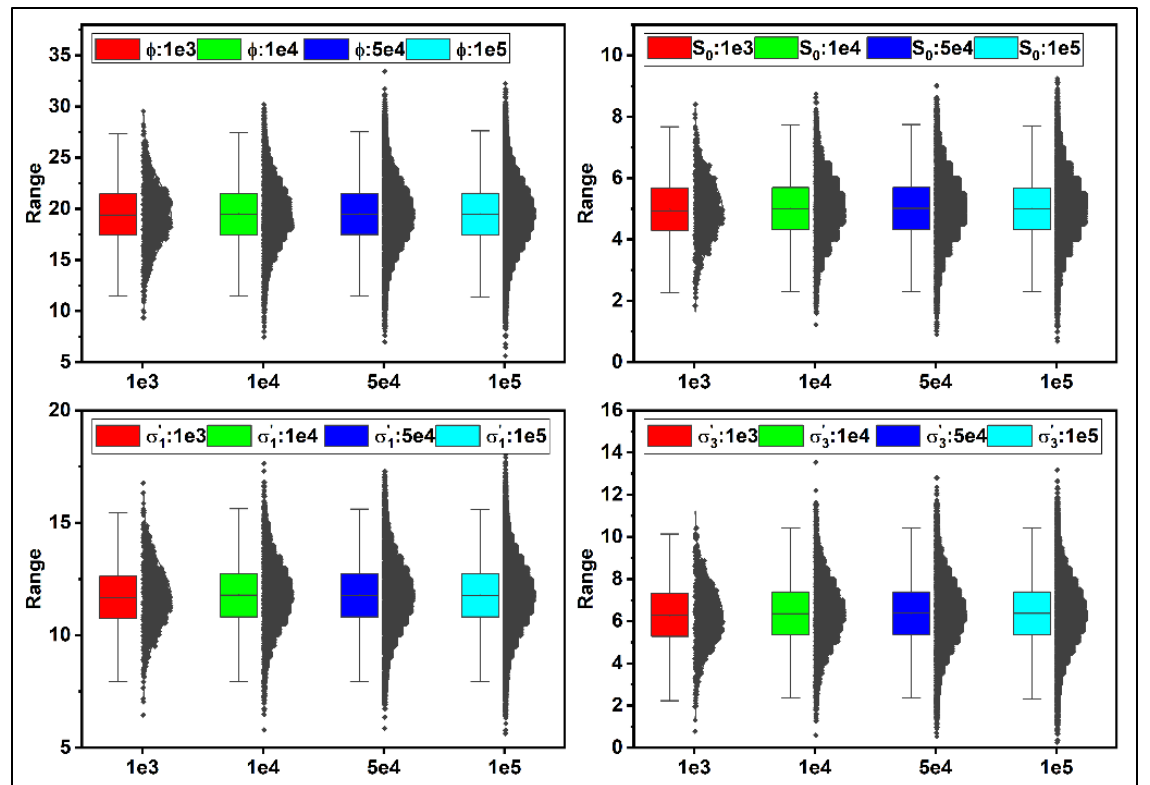
Figure 6. The graphs depict the probability distribution function of ϕ , S 0 , σ ’ 1 , and σ ’ 3 for different sample sizes. The colors red, green, blue, and cyan indicate the distribution range for 1e+03, 1e+04, 5e+04, and 1e+05 samples generated using MC algorithm.